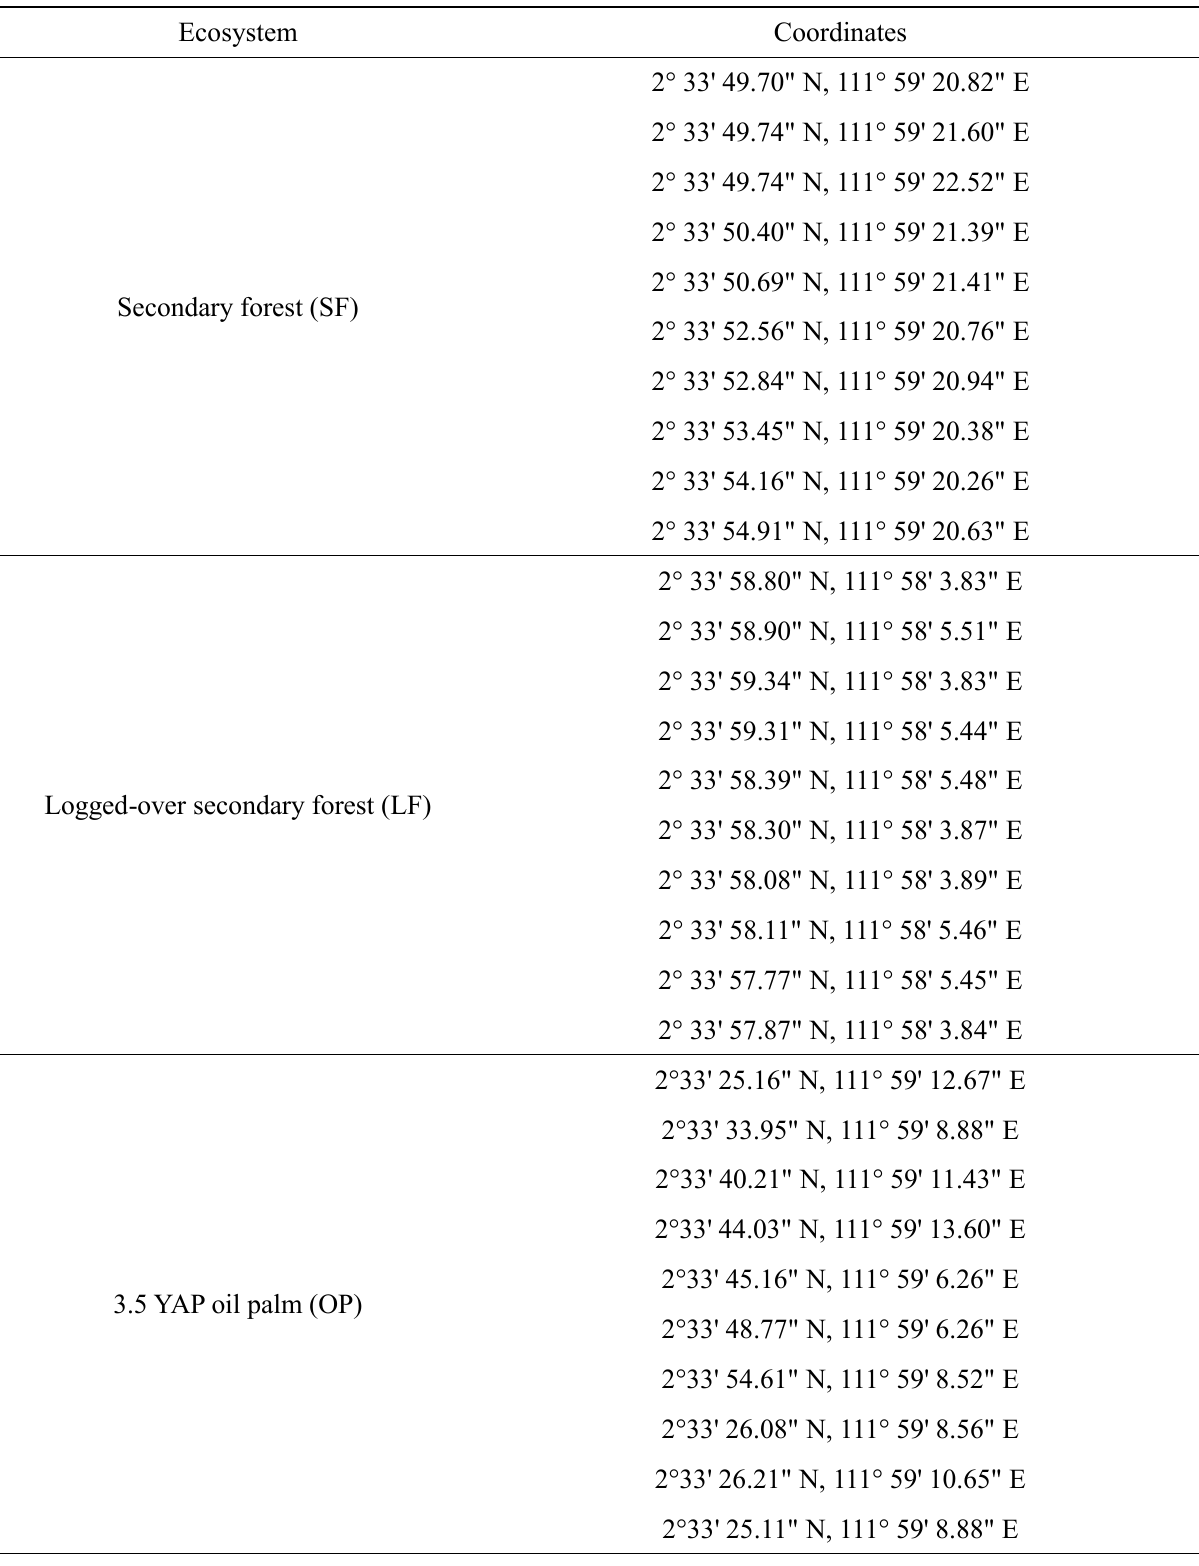
Table A1. The geographic coordinates (latitude, longitude) of sampling sites in the three Alan Bunga peat swamp forest ecosystems (Sarawak, Malaysia). YAP = years after